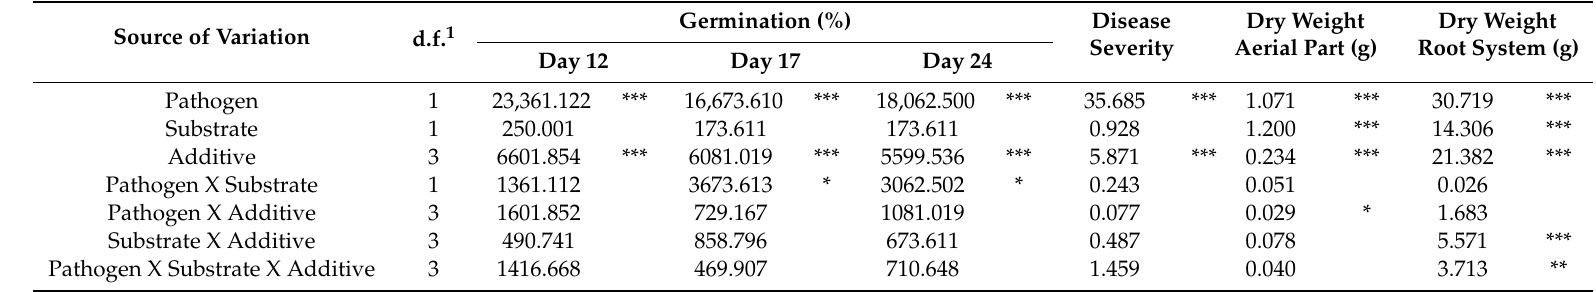
Table 2. Means squares of the combined analyses of variance for germination in 12, 17 and 24 days after sowing, disease severity 45 days after sowing, and dry weights of aerial part and root system.